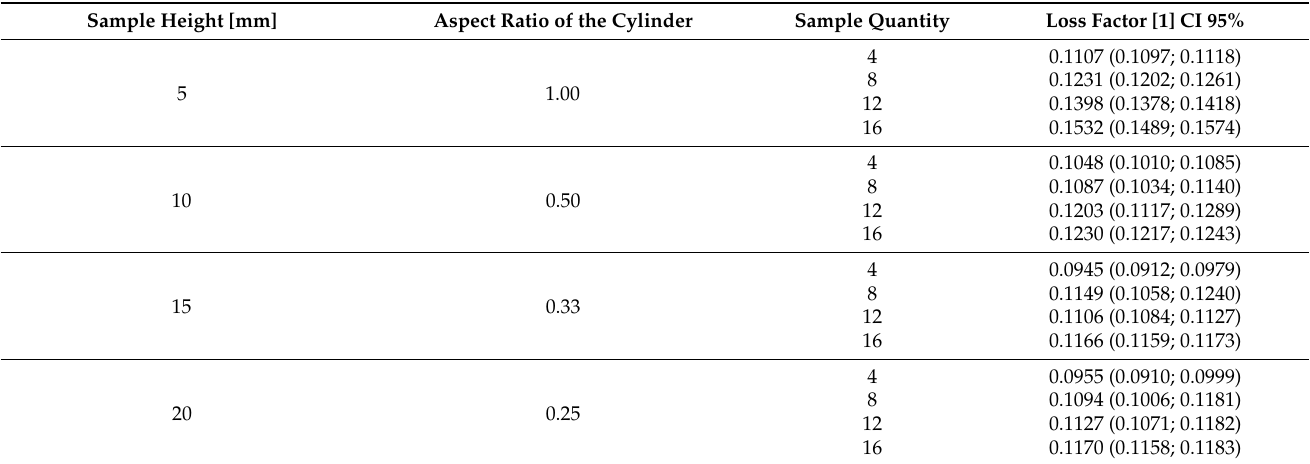
Table 9. Results of a loss factor in the tested